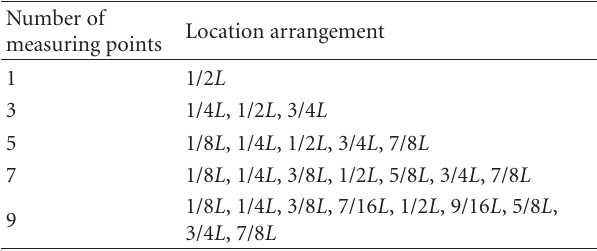
Table 4: Comparison on CPU processing times from the two